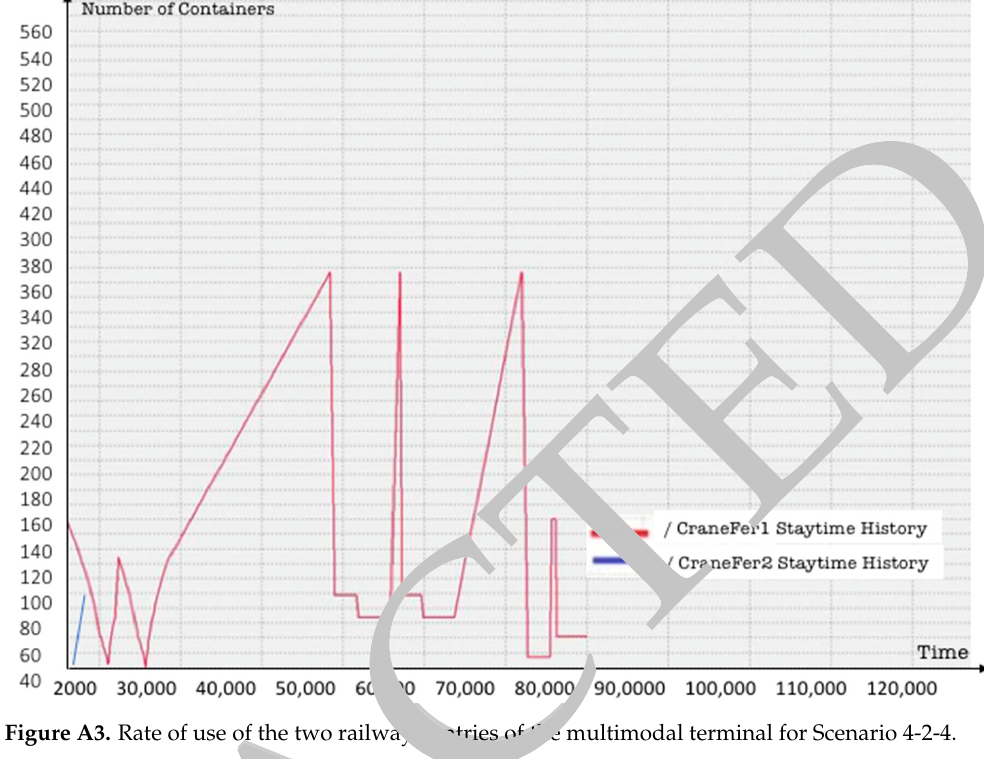
Figure A3. Rate of use of the two railway gantries of the multimodal terminal for Scenario 4-2-4.